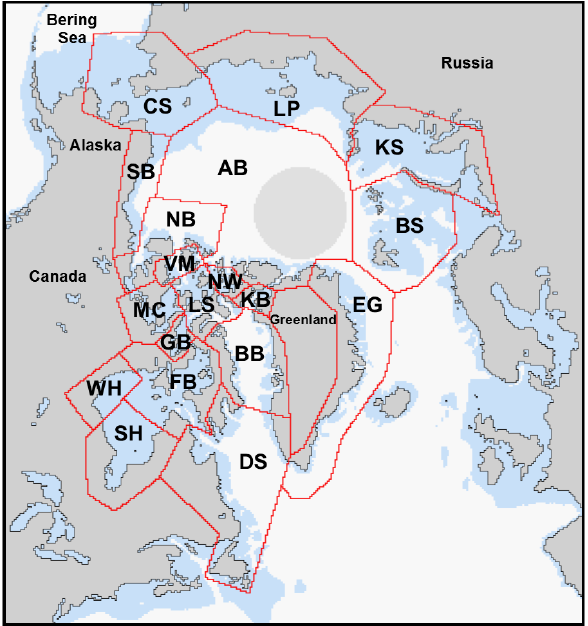
Figure 1. Map of the 19 PBSG polar bear subpopulation regions, with shallow depths ( ≤ 300m) in blue. See Table 1 for subpopula- tion names corresponding to the abbreviations on the